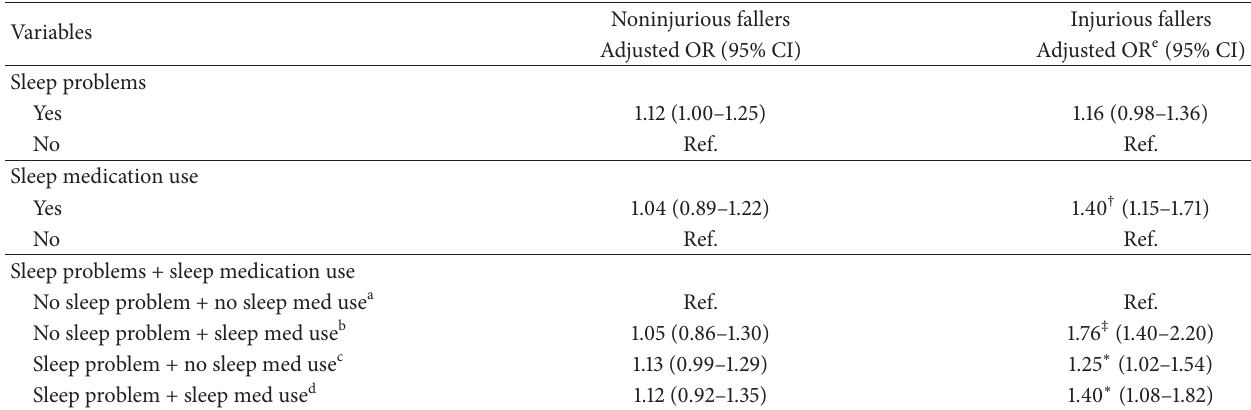
Noninjurious fallers